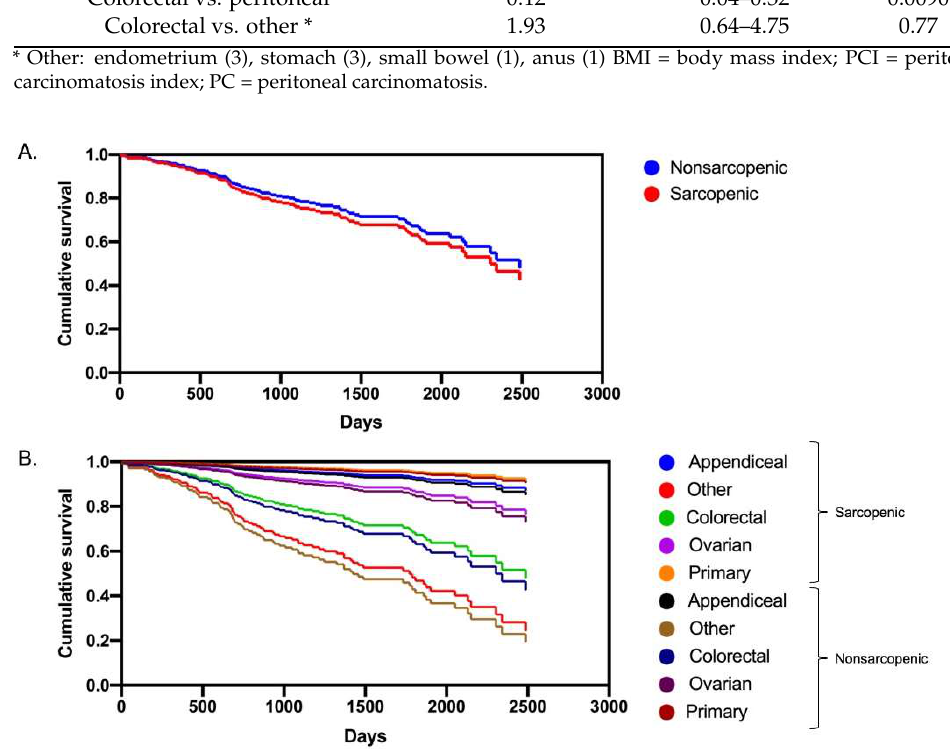
metastases ( B neal metastases ( B ).